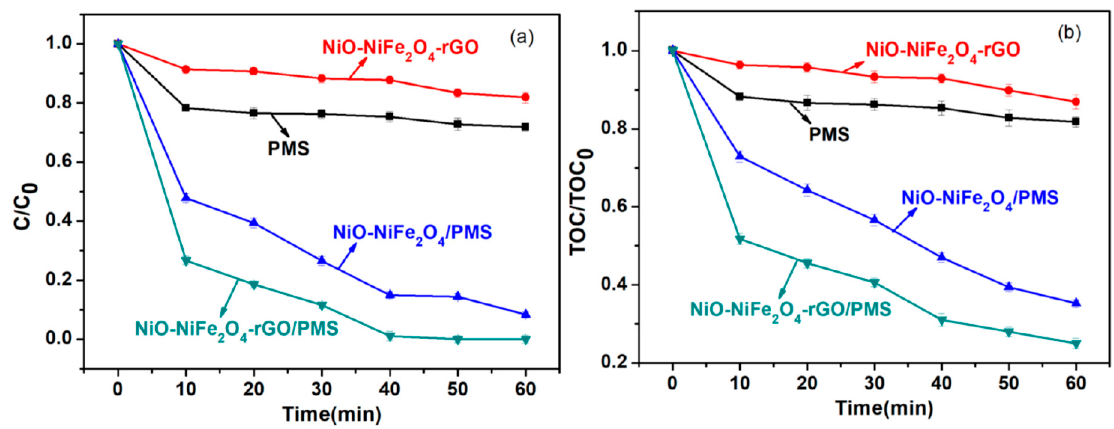
Figure 6. The degradation of ( a ) rhodamine B (RhB) concentration and ( b ) total organic carbon (TOC) in different systems.